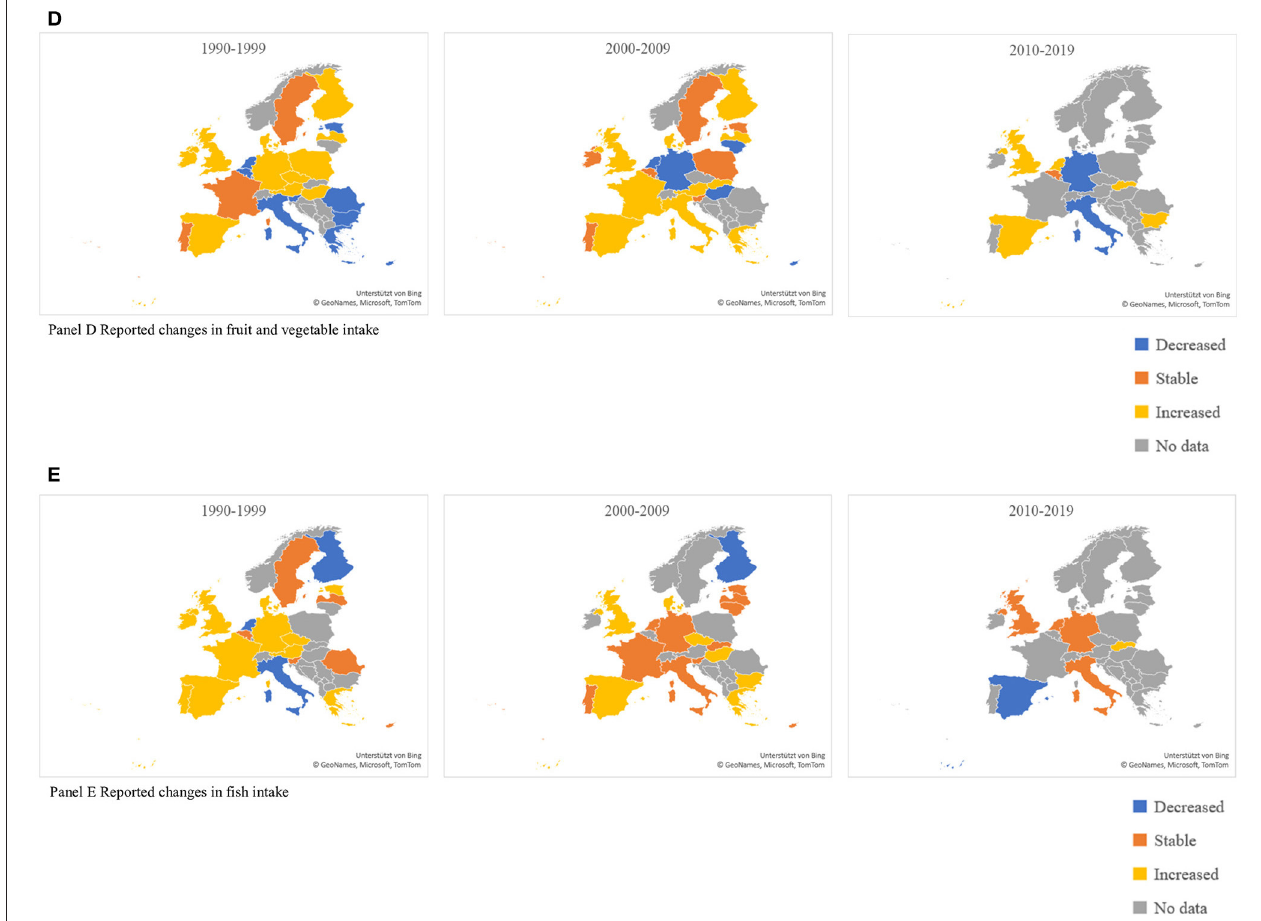
FIGURE 2 | Reported changes in dietary intakes in the European countries (1990–2019), by decade. (A) Changes in sugar intake. Decreased, Stable, Increased, No data. (B) Changes in carbohydrate intake. Decreased, Stable, Increased, No data. (C) Changes in saturated fatty acid intake. Decreased, Stable, Increased, No data. (D) Changes in fruit and vegetable intake. Decreased, Stable, Increased, No data. (E) Changes in fish intake. Decreased, Stable, Increased, No data.